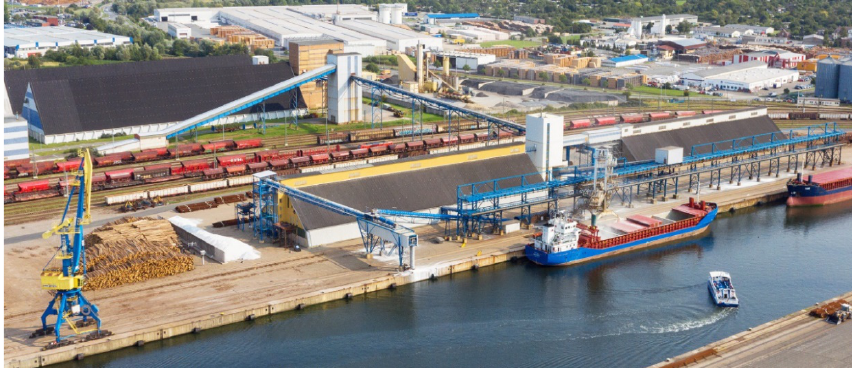
Fig. 1. Bulk cargo plant in the seaport of Wismar [Compiled by the